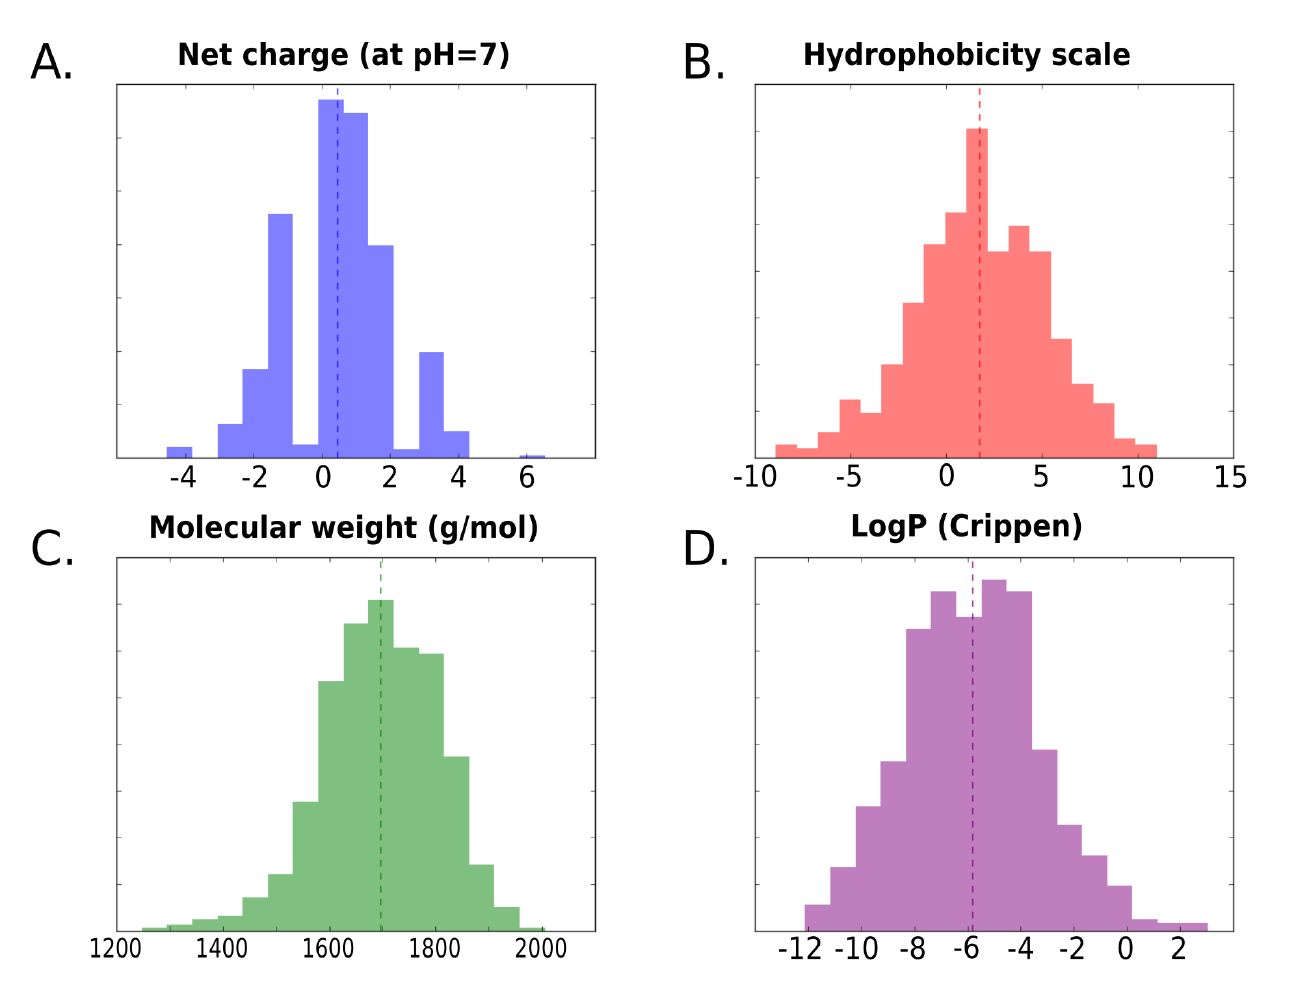
Figure 3. Distribution of peptide properties calculated with sequence-based functions of PepFun. For the 655 peptides reported as binders of the MHC class II allele, four properties were calculated: the net charge at pH = 7 ( A ), hydrophobicty with the Eisenberg scale [23] ( B ), the molecular weight (g/mol) ( C ) and the Crippen LogP [24] ( D